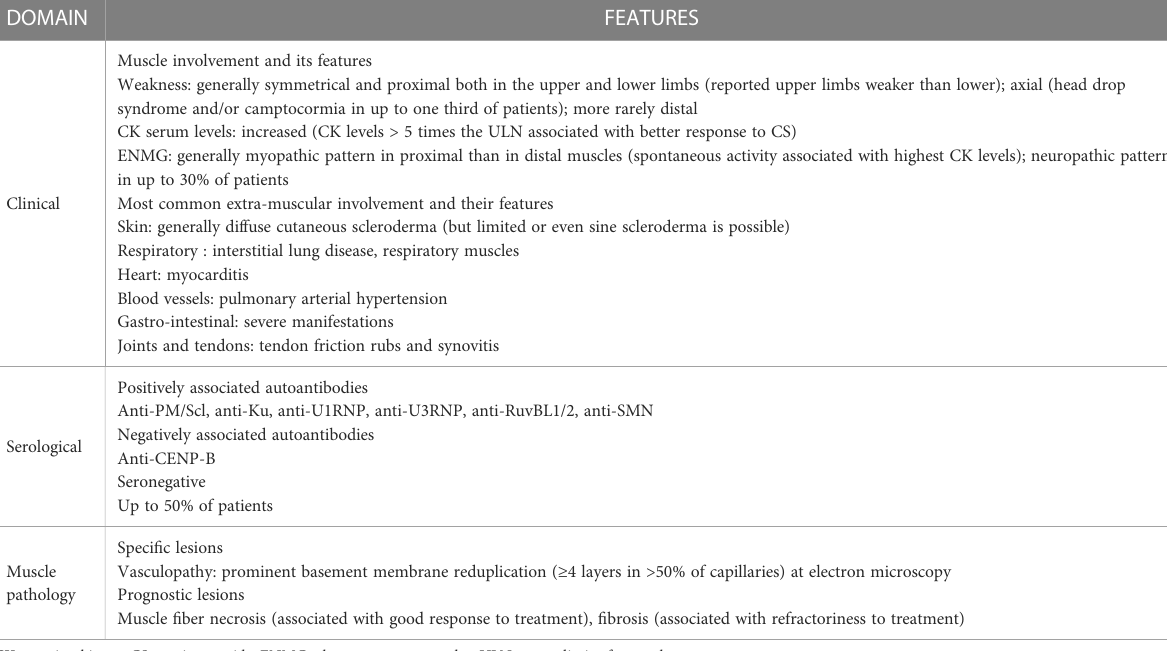
TABLE 5 Distinguishing clinical, serological and pathological features of scleromyositis.